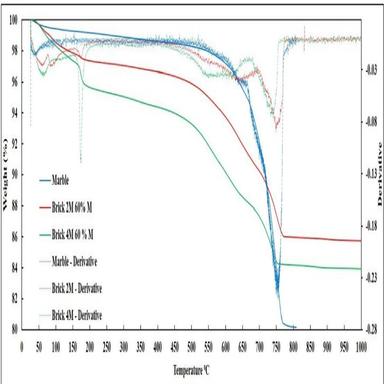
TGA thermal decomposition curves obtained for hybrid geopolymeric composite samples prepared at different molarities and 60% marble waste content.